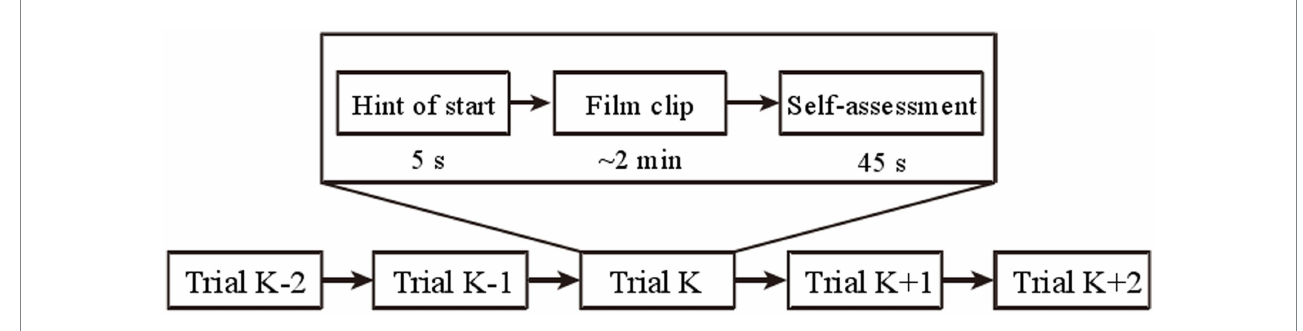
FIGURE 8 Protocol of SEED-IV for four emotions (Zheng et al., 2018). Reproduced with permission from IEEE. Licence Number: